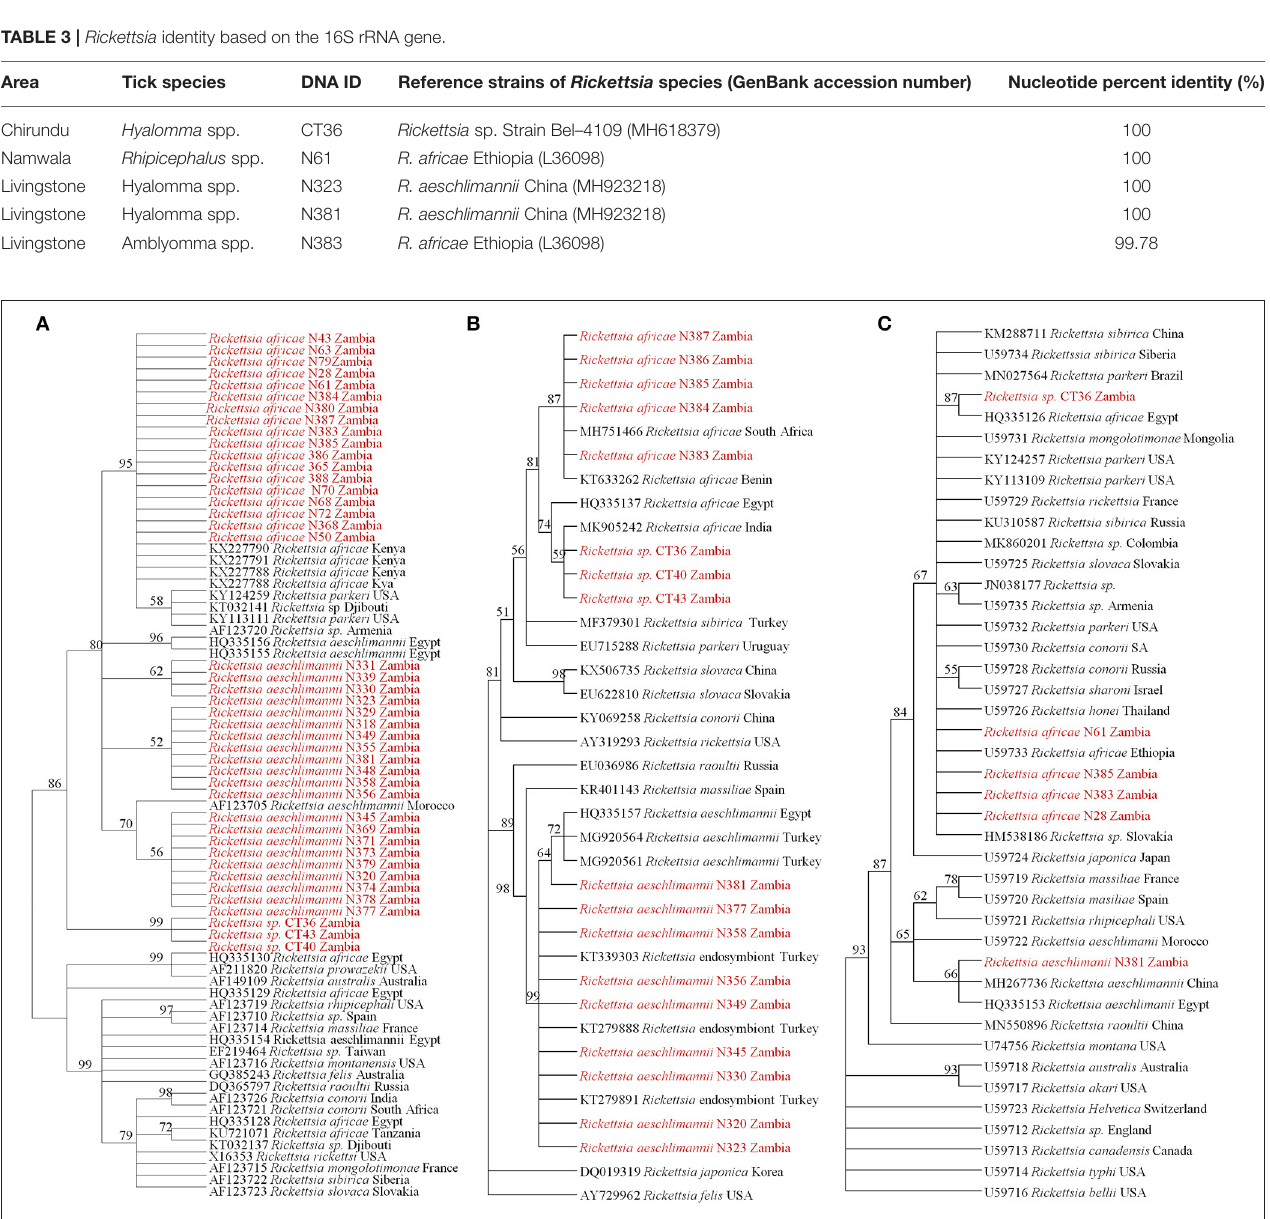
FIGURE 2 | Phylogenetic relationships of the ompB (A) , ompA (B) , and gltA (C) genes of Rickettsiae detected from ticks in Zambia. Phylogenetic analysis was based on 397, 460, and 596 bp of the ompB , ompA , and gltA genes, respectively. Numbers at branch nodes indicate bootstrap values ≥ 50%. The reference sequences included in the analyses are shown by their GenBank accession number, species, and country of origin. The Rickettsiae characterized in the present study are in red text.